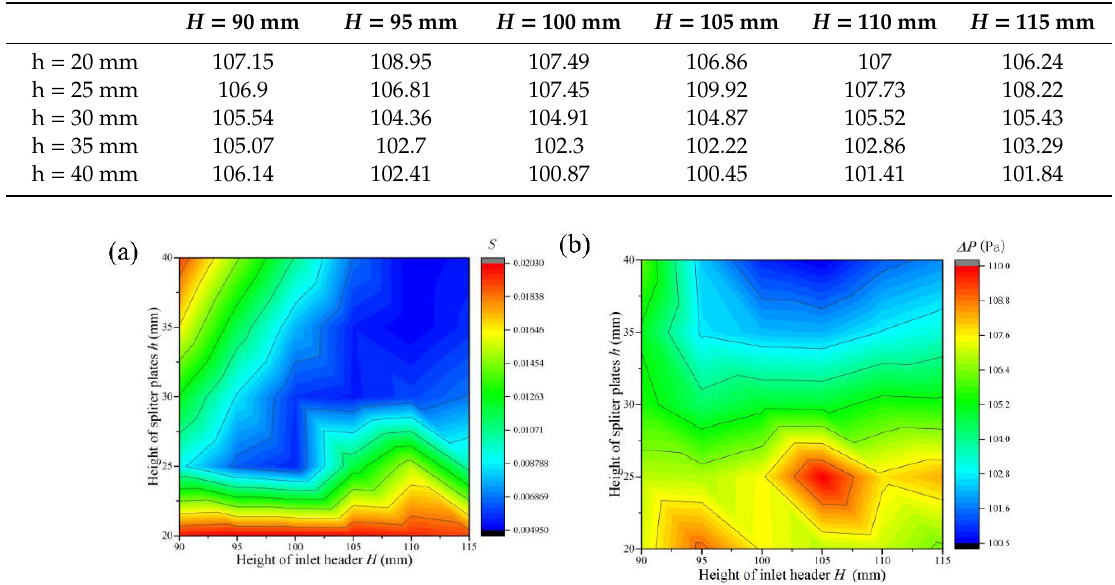
Figure 13. Contour map under different combinations of H and h : ( a ) Flow maldistribution degree; ( b ) pressure drop.